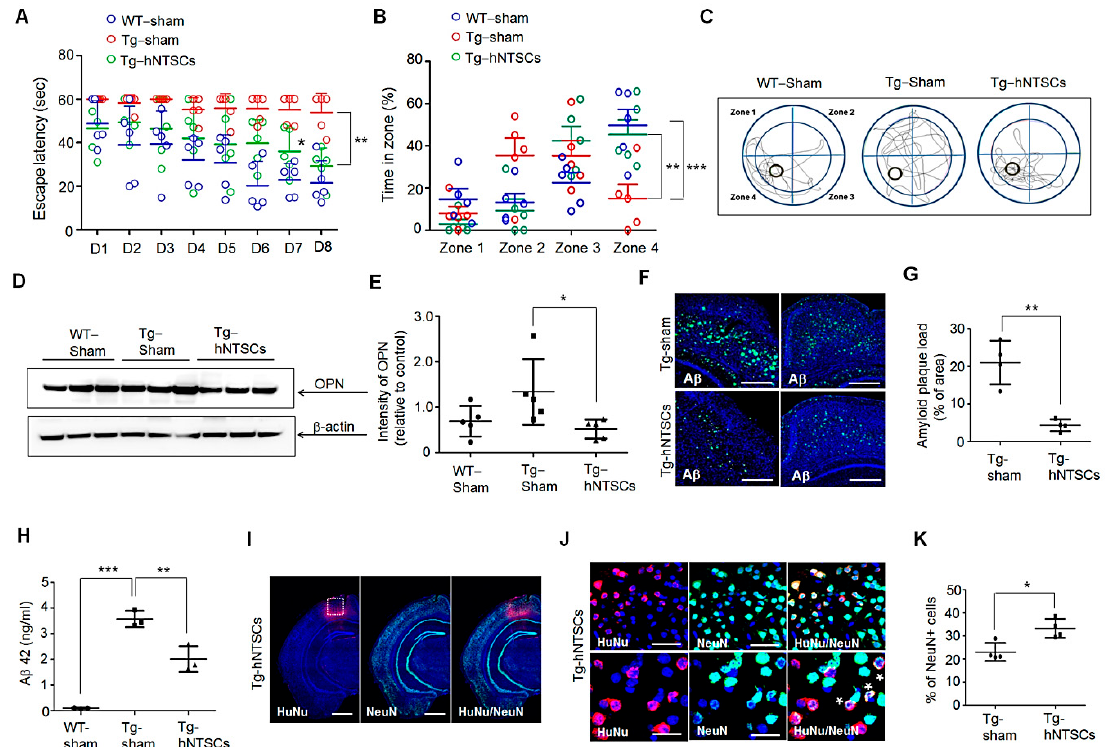
Figure 6. Effects of hNTSC transplantation on cognitive deficit and the expression of OPN in the brain of 5 × FAD mice. ( A ) The escape latency was the time in each group to find a hidden platform (up to a maximum of 60 s). For the multiple comparison tests, two-way ANOVA was used to determine whether group differences were statistically significant. * p < 0.05, ** p < 0.01. ( B , C ) Probe test images for remembering platform position in zone 4 in each group. Data were expressed as the percentage (%) of time spent in zones 1–4 within 60 s. For the multiple comparison tests, two-way ANOVA test was used to determine whether group dif- ferences were statistically significant. ** p < 0.01, *** p < 0.001. ( D ) Western blots of SDS-PAGE gels of proteins extracted from brain tissues of WT-sham, Tg-sham, and Tg-hNTSCs mice using a primary anti-OPN antibody at 7 weeks after stem cell transplantation. β -actin was used as a loading control. ( E ) The values shown are the mean (SD). For nonparametric multiple comparison tests, one- way ANOVA was used to determine whether differences between groups were statistically significant. * p < 0.05. ( F ) Confocal mi- croscopy images of Tg-sham and Tg-hNTSC brain sections with an antibody against 6E10 to detect A β deposition (green) at 7 weeks after stem cell transplantation. Nuclei were labeled with DAPI (blue). ( G ) A β plaque loads were quantified in the hippocampus and cortex of Tg-sham and Tg-hNTSCs (n = 4 per group). The values shown are the mean (SD). The significance of differences between two different samples was determined with Student’s t -test. ** p < 0.01. ( H ) Soluble A β 42 levels in brain tissue lysates of WT-sham, Tg-sham, and Tg-hNTSCs at 7 weeks after stem cell transplantation (n = 3 per group). Values are the mean (SD). For the nonpara- metric multiple comparison tests, one-way ANOVA was used to determine whether group differences were statistically significant. ** p < 0.01, *** p < 0.001. ( I ) Confocal microscopy image of the brain of Tg-hNTSCs after double-staining of brain tissue sections with antibodies to HuNu (red) and NeuN (green). Nuclei were labeled with DAPI (blue). Scale bars: 200 μ m. ( J ) A set of higher-amplifi- cation image of the part marked with the box in Figure 6I. HuNu–NeuN double-positive cells are marked with *. Scale bars: 100 μ m, 500 μ m. ( K ) NeuN-positive cells were counted in the cortex of Tg-sham and Tg-hNTSCs (n = 4 per group). Values are the mean (SD). The significance of differences between two different samples was determined with Student’s t-test. ** p < 0.01. All data are repre- sentative of two or three independent experiments. 4. Discussion Regenerative therapy using stem cells has been regarded as a promising and safe approach for the restoration of altered or lost cellular functions. Although the underlying mechanisms of stem-cell-based therapy need more clarification, several preclinical studies have generated encouraging results [23]. There have been an increasing number of stem